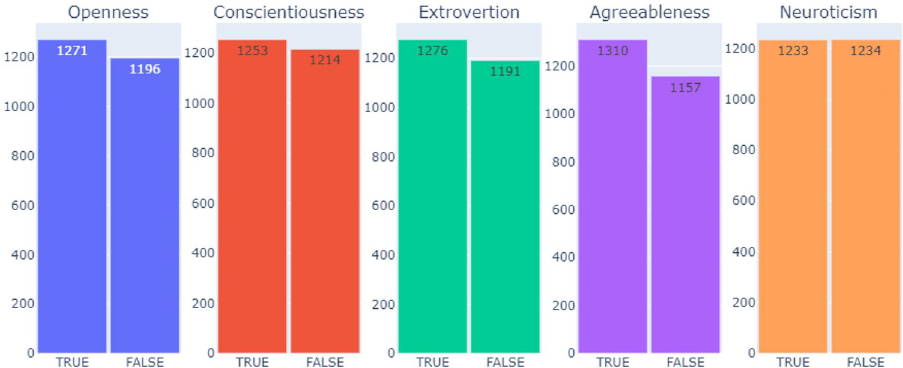
Figure 2. The distribution of labels in each five personality traits in Essays Dataset.